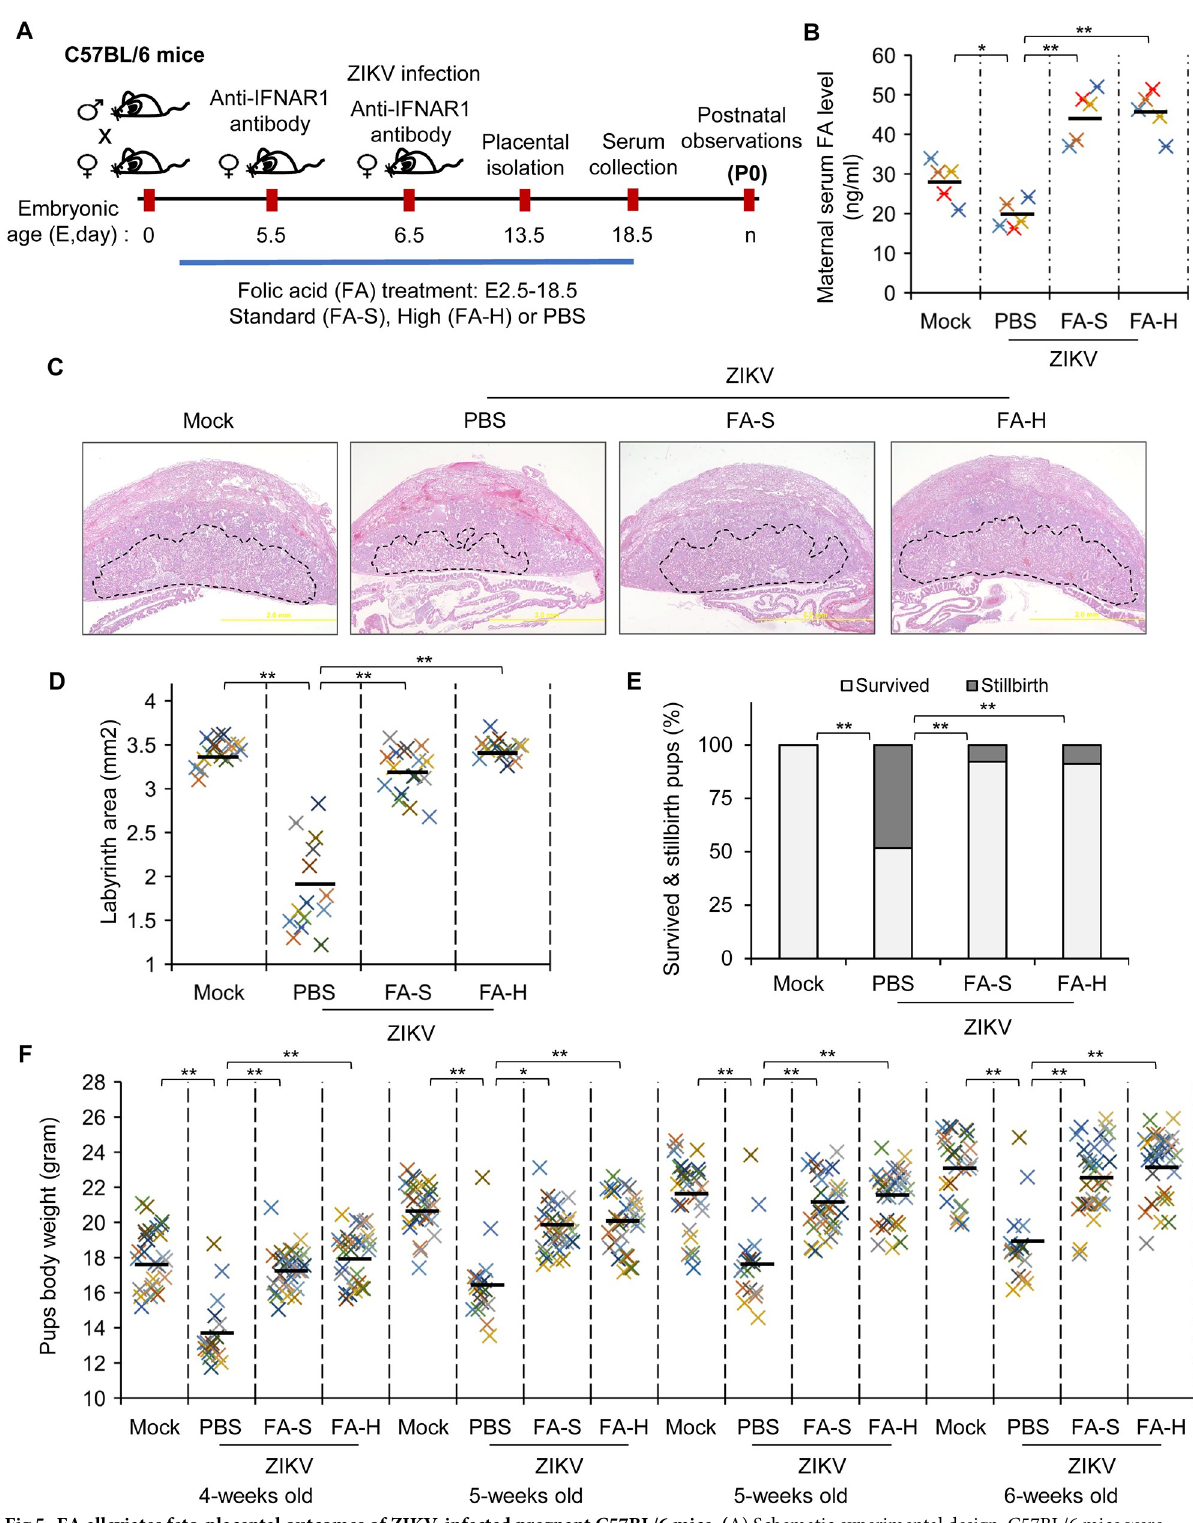
Fig 5. FA alleviates feto-placental outcomes of ZIKV-infected pregnant C57BL/6 mice. ( A) Schematic experimental design. C57BL/6 mice were mated overnight. Pregnant mice were treated with FA-S (0.164 mg/kg bw/mouse/oral/day) or FA-H (0.328 mg/kg bw/mouse/oral/day) at E2.5–18.5. PBS was used as solvent control. Pregnant mice were treated with purified anti-mouse IFNAR1 antibody (0.5 mg/kg bw/mouse/intraperitoneal) at